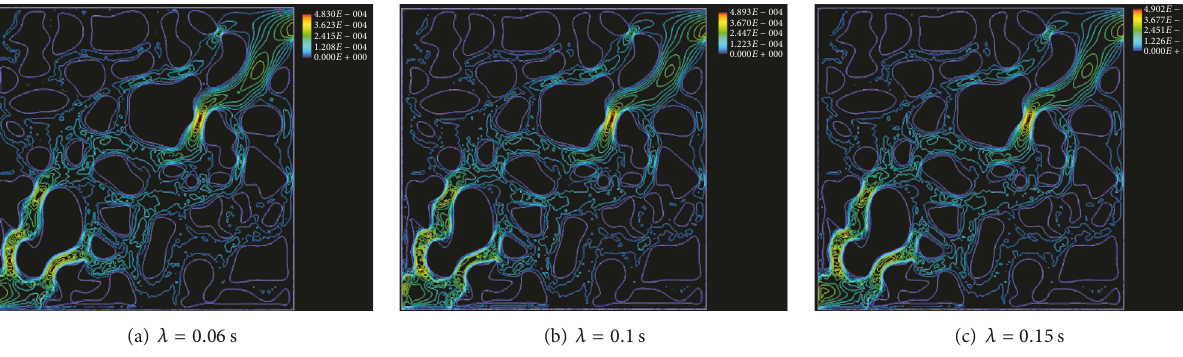
Figure 10: Velocity contours with different relaxation time through complex micromodel ( 𝑡 = 2.0 s).